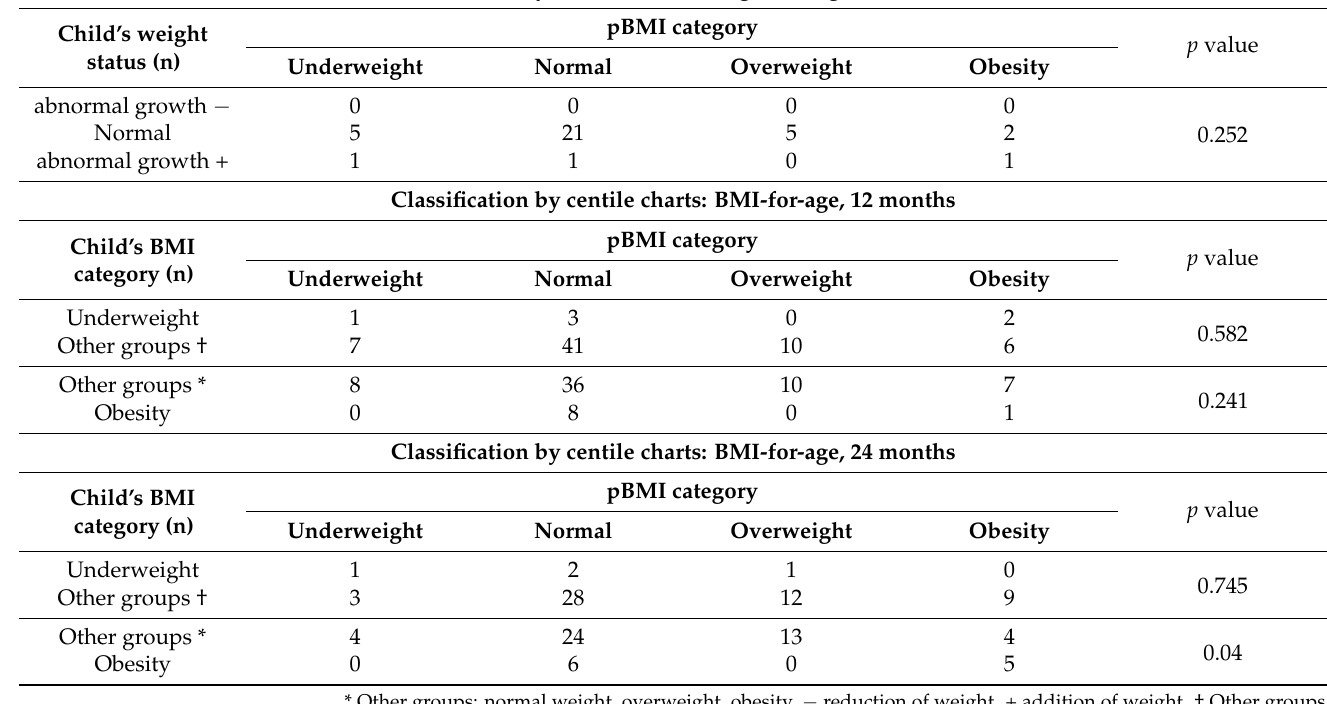
Classification by centile charts: weight-for-age, 24 months